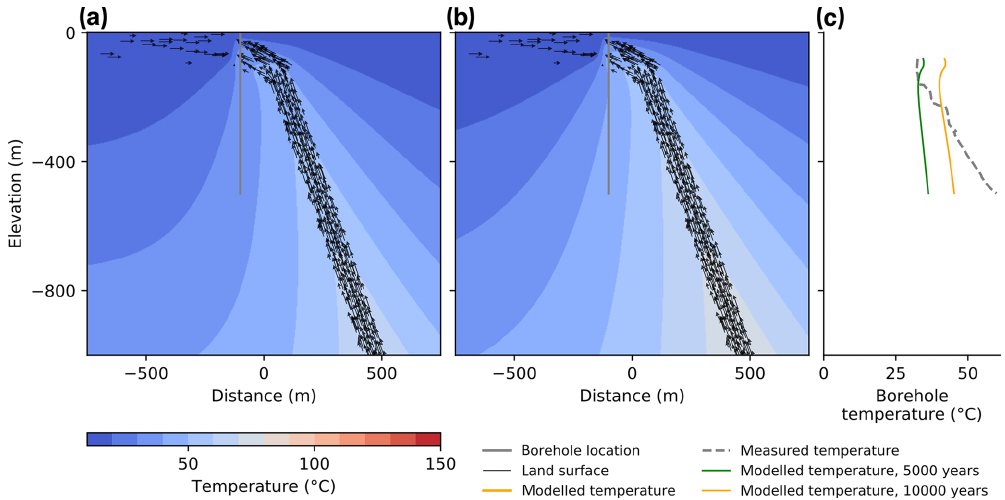
Figure 9. Modelled temperatures and AHe ages for the Brigerbad hydrothermal system after 5000 (a) and 10000 (b) years of hydrothermal activity, assuming a narrow flow conduit of a 100m. The results show a relatively poor fit to the measured borehole temperature data (c) .